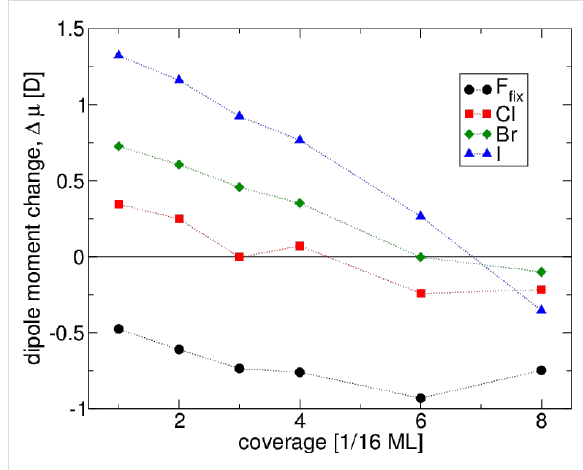
Figure 5: Calculated normalized dipole moment as a function of the coverage of fluorine, chlorine, bromine and iodine on Pt(111).